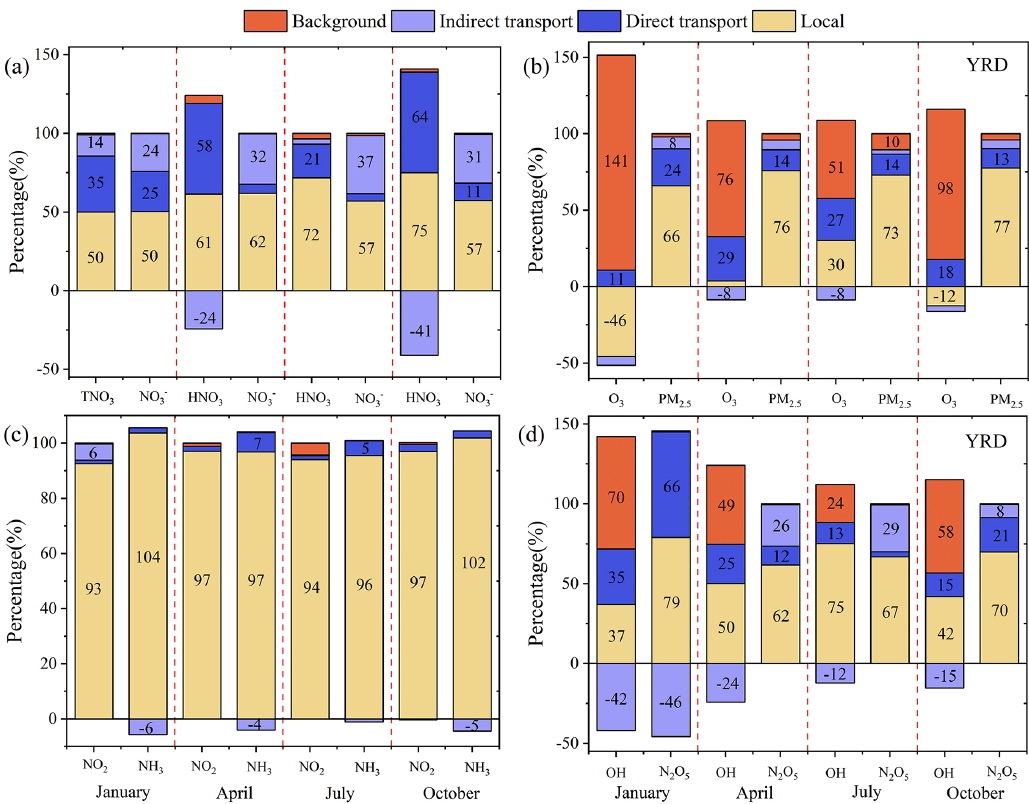
Figure 3. Contributions of background, local, indirect, and direct transport to nitrate-related species in 4 months of 2017 for the entire YRD region (a–d) . Nitrate-related species represent NO 3 − , HNO 3 , PM 2 . 5 , O 3 , NO 2 , NH 3 , OH, and N 2 O 5 . The contributions of HNO 3 in January 2017 are shown in Fig.